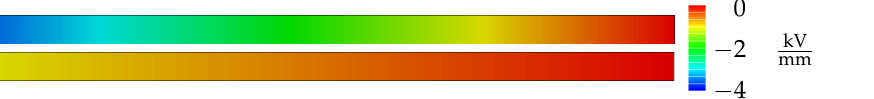
Figure 22. Comparison of electric field E 3 distribution based on linear (top) and quadratic (bottom) element in the cantilever